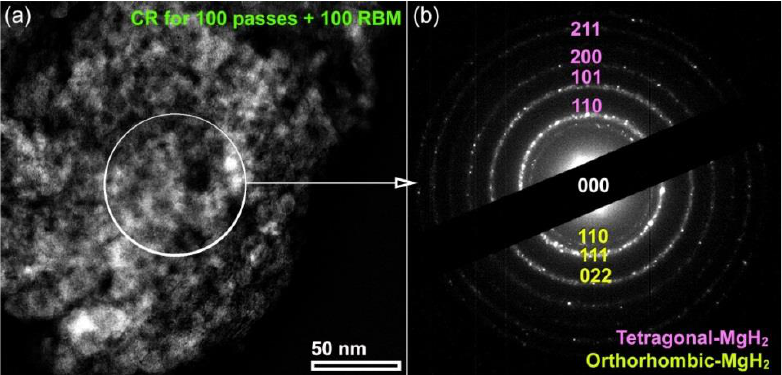
Figure 4. ( a ) DFI of Mg-rods obtained after CR for 100 times followed by 100 h of RBM and ( b ) related SADP.